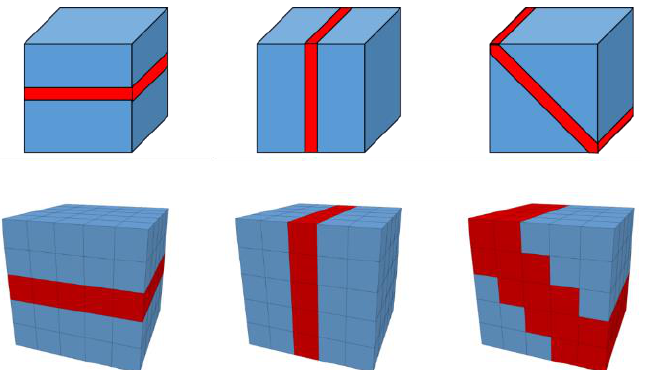
Figure 7. Reconstructed sample with flexible membrane as outer vertical boundary.